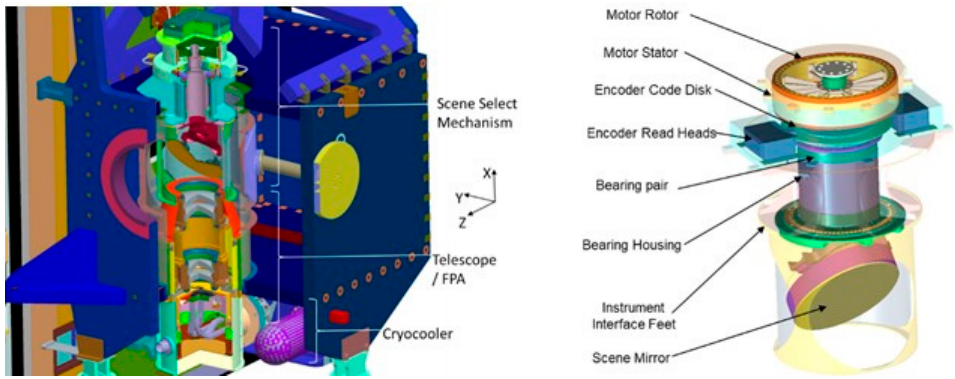
Figure 2. TIRS instrument showing the scene select mirror which points the TIRS focal plane toward deep space, the blackbody, and Earth collects.